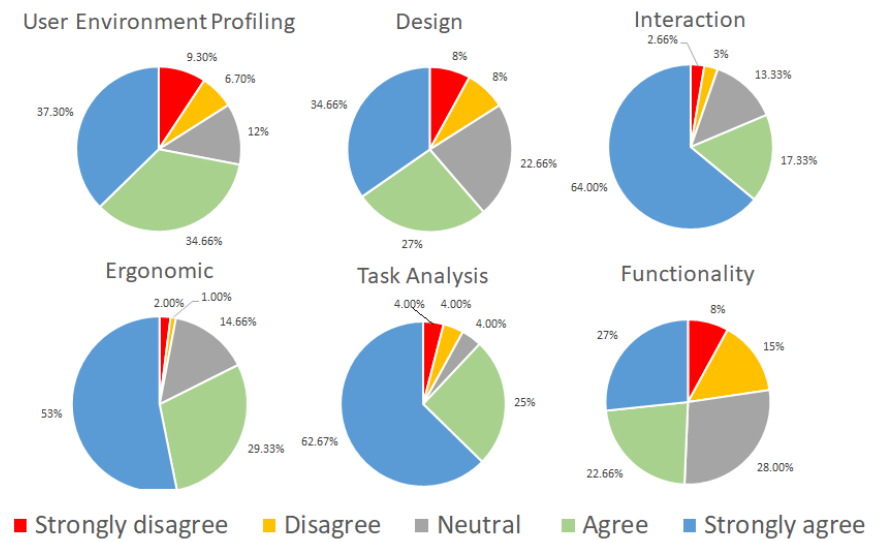
Figure 11. Results for each section of the usability test.